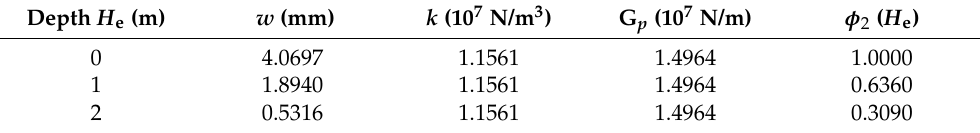
Table 4. Results for a beam embedded in a transversely isotropic foundation ( E T 21 = 28.8 MPa).